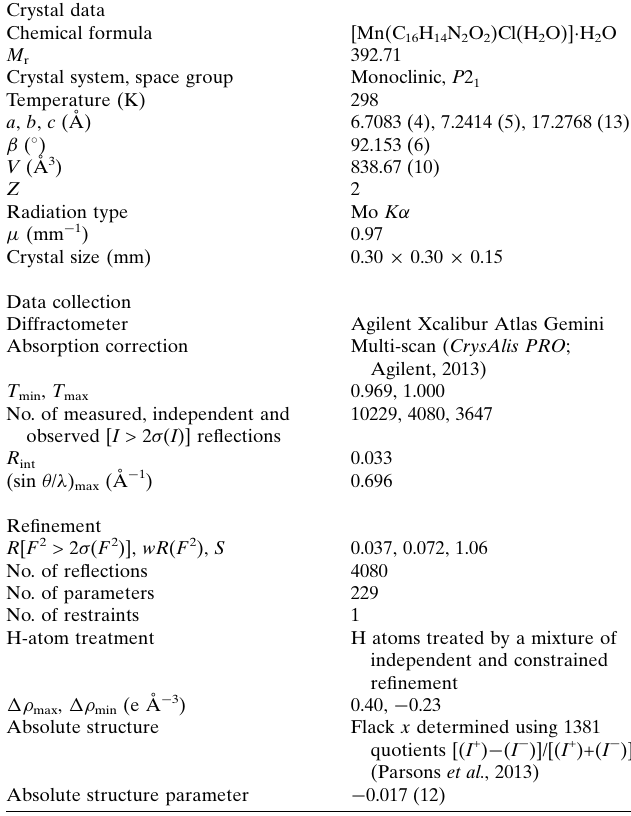
Table 3 Experimental details. Crystal data Chemical